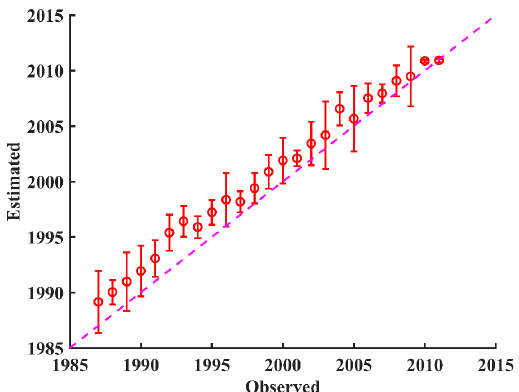
Figure 11. Illustration of underestimating the establishment year of rubber plantations by using LSWI leafon_min